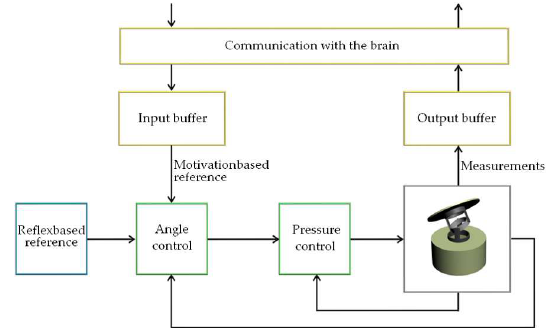
Figure 8: Control scheme taking place locally in each segment.